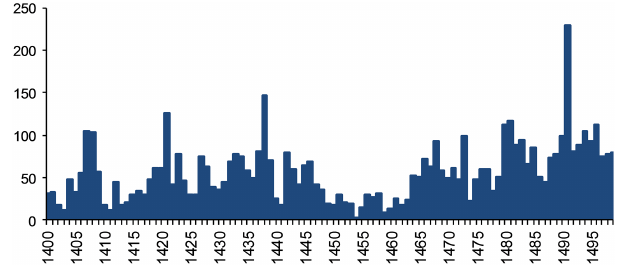
Figure 2. Annual distribution of the sources (Camenisch, 2015).